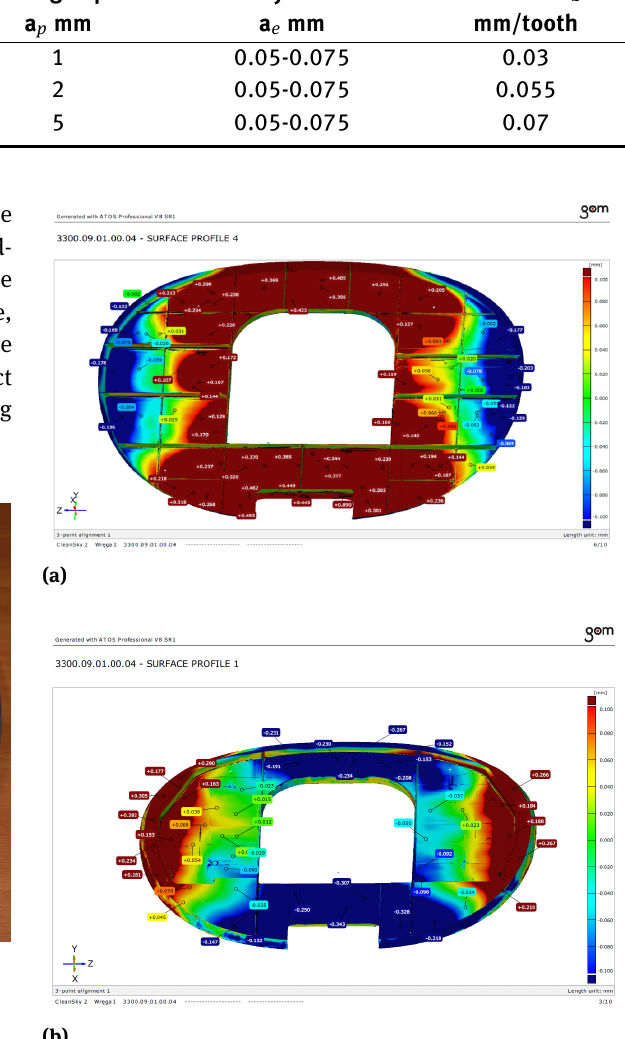
The frame was optically measured by the GOM scan- ner in order to verify its shape, dimensions, and spatial displacements (Figure 4, Figure 5). This research allowed to determine linear dimensions of the particular frame ele- ments and to create digital and contour maps showing the frame stereometry. Those maps mostly allowed evaluation ofthedeformationpotentialofthelargeframesurface.The deformations can be caused by internal stresses generated in the structure during mechanical processing [2, 3]. The dimensions analysis shows that the deviations of the lin- ear dimensions fall within the predicted tolerances. The block is mainly deformed towards the shorter axis of sym- metry and the displacements are symmetrical towards the longer axis of symmetry. The highest relative displacement values are 0.57 mm. The GOM scanner ensures the precise measurements with a margin of error of +/− 0.25 mm. How-